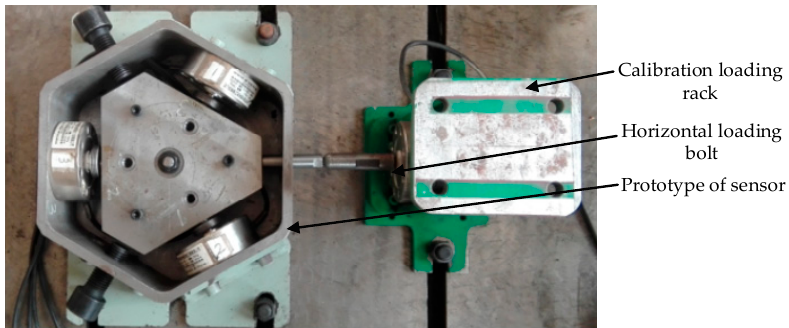
Figure 20. The calibration experiment of the horizontal loading.